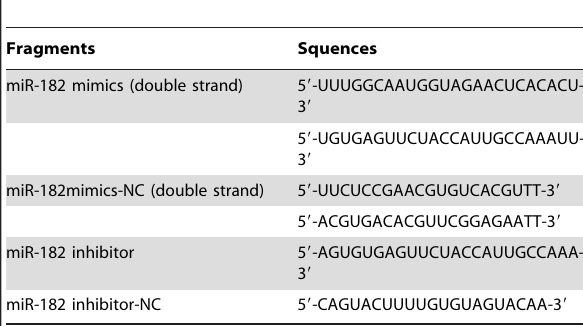
Table 1. Sequences of miR-182 mimics and inhibitors.